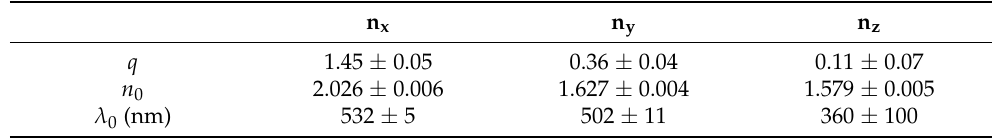
Table 12. Sellmeier parameters for the refractive index dispersion of Equation (24). Adapted with permission from [95]. © The Optical Society.